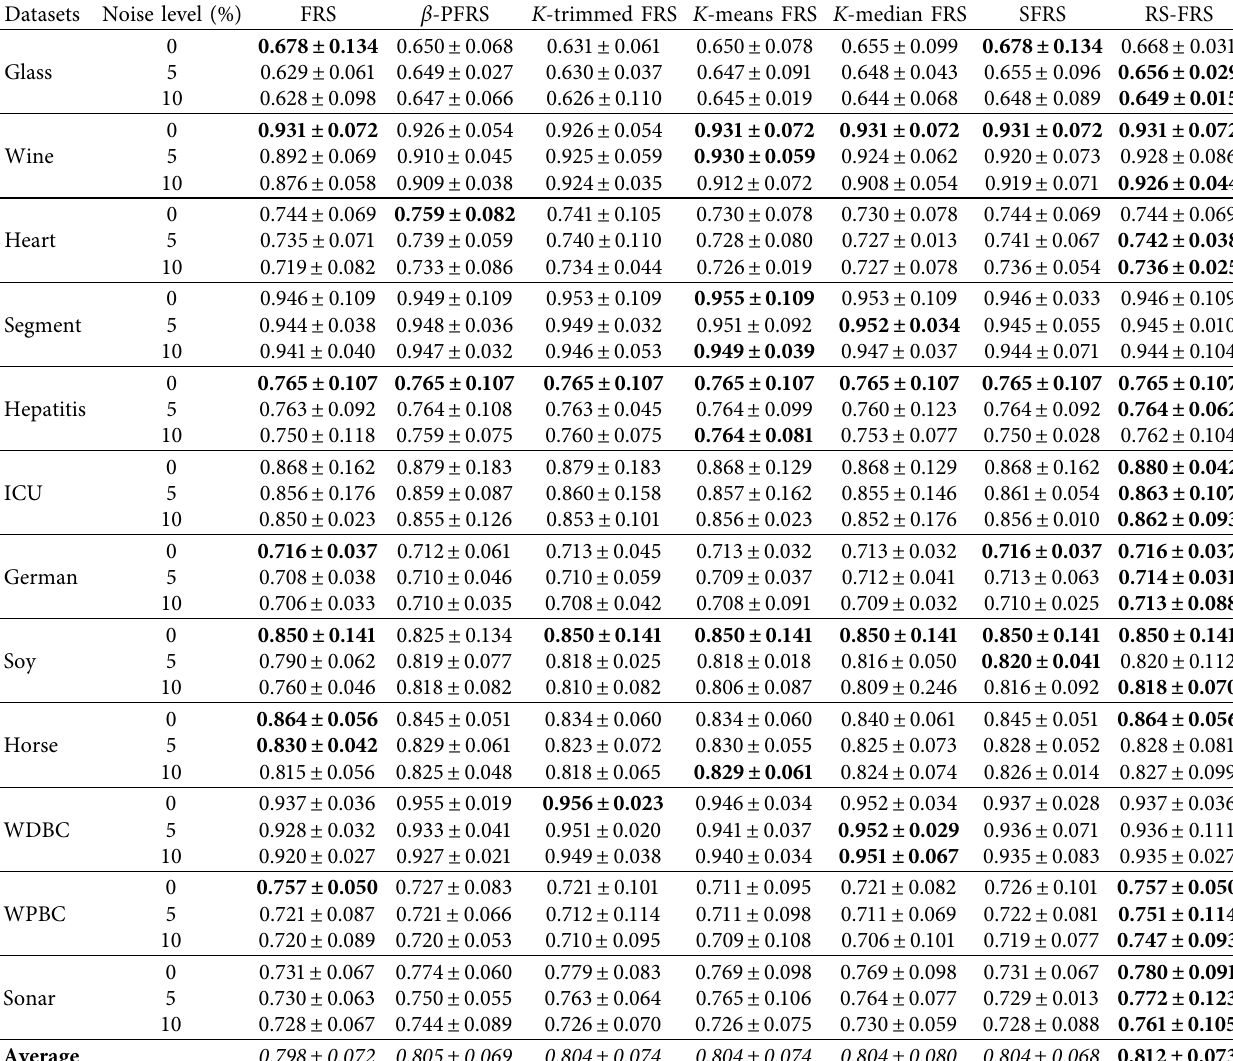
Table 2: Comparison of classification performance of different FRS models on KNN in original and noisy data. Datasets Noise level (%)